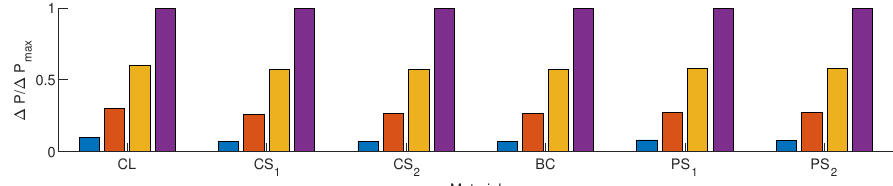
Figure 10. Normalized pressure drop as a function of inlet air velocity ( u ) for a constant water flow of 6.2 L min − 1 m − 1 . The colour bars corresponds to different air velocities: blue: u = 0.5 m s − 1 , red: u = 1.0 m s − 1 , orange: u = 1.5 m s − 1 and magenta: u = 2 m s − 1 .